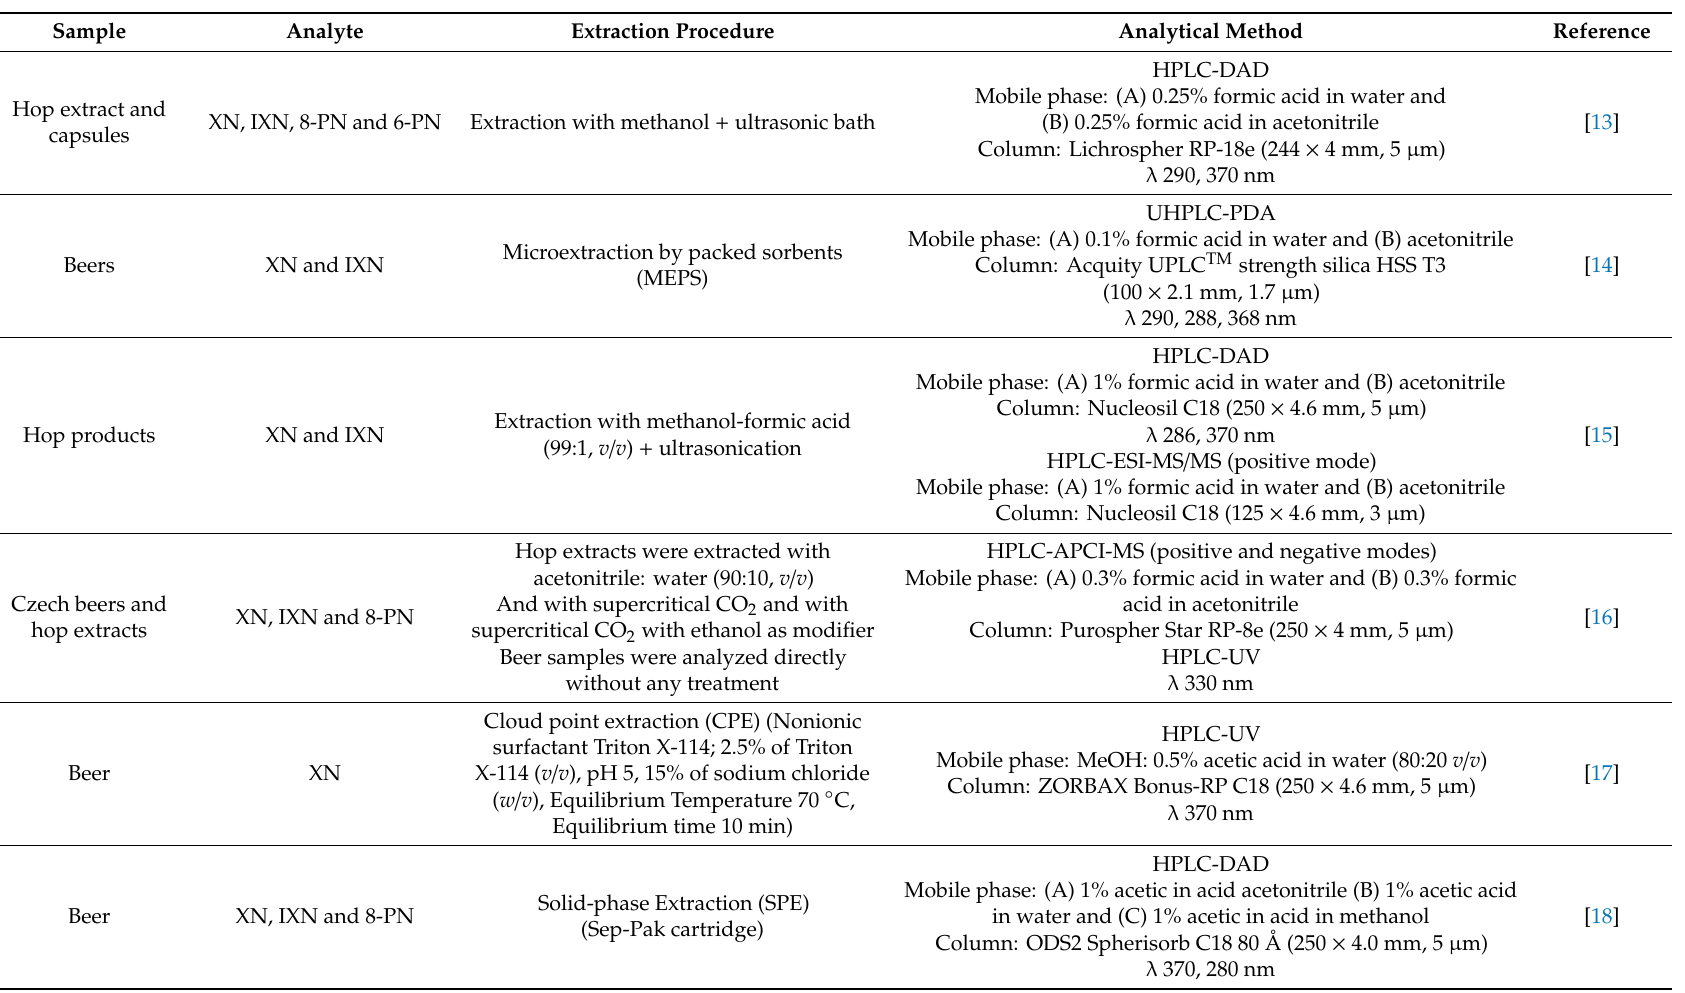
Table 1. An overview of the analytical techniques and extraction procedures for xanthohumol (XN) and prenylated flavonoids’